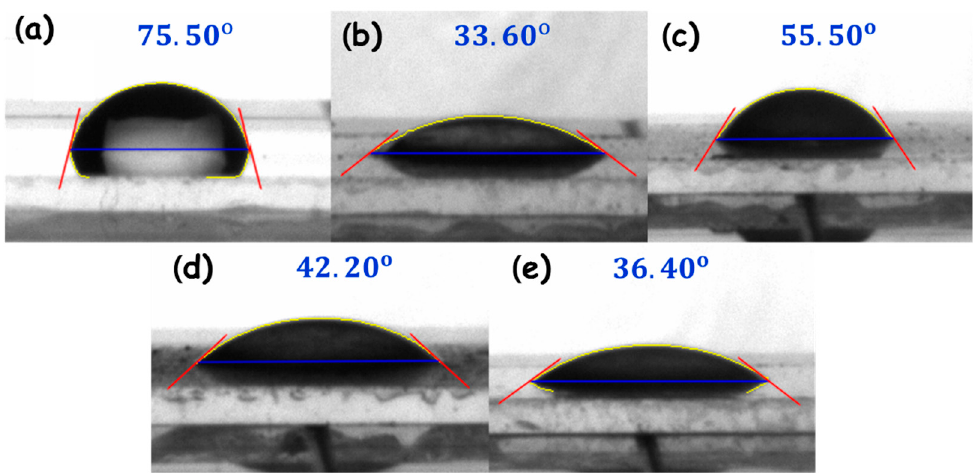
Figure 1. Contact angles of ( a ) bare indium tin oxide (ITO), ( b ) polyacrylic acid (PAA), ( c ) CuO–PAA, ( d ) Fe 2 O 3 –PAA and ( e ) ZnO–PAA coated on ITO electrode.